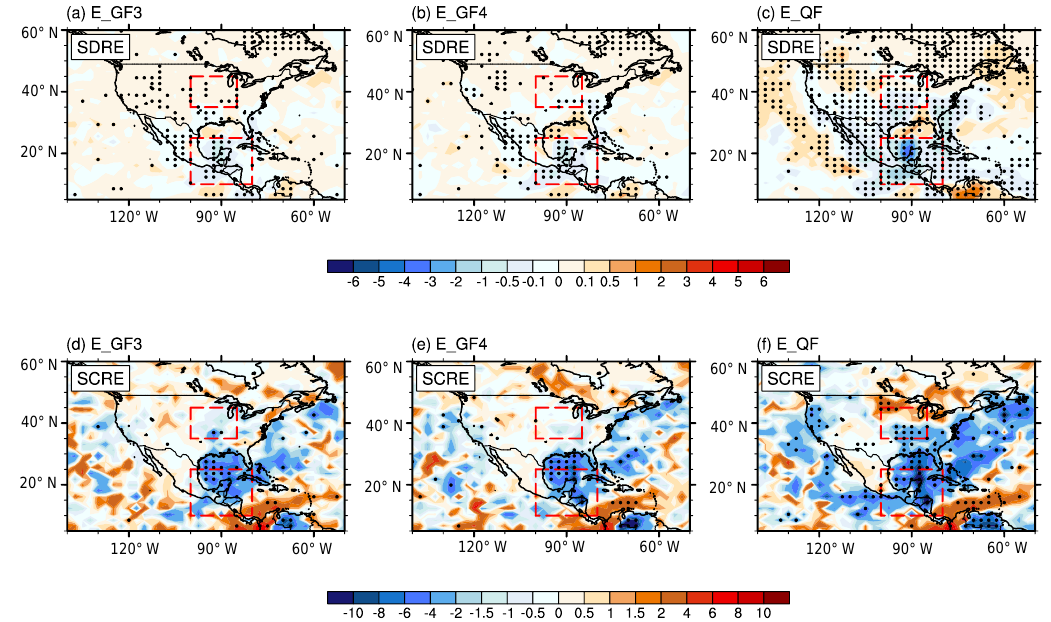
Figure 7. Spatial distributions of 10-day-average (1–10 April) ensemble mean fire aerosol shortwave direct radiative effect (SDRE) and shortwave cloud radiative effect (SCRE) (Wm − 2 ) in group B simulations. Dots denote regions where SDRE is statistically significant at the 95% confidence level based on the Kolmogorov–Smirnov (KS)